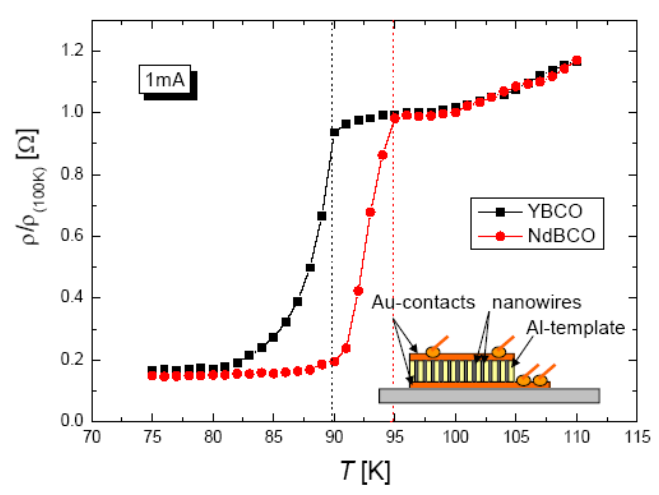
Figure 9. Resistance measurements on YBCO and NdBCO nanowire arrays fabricated using commer- cial AAO templates. The applied current was 1 mA. NdBCO shows the onset of the superconducting transition at 95 K, while YBCO has a T c of 88 K (indicated by red and black dashed lines). The inset illustrates the arrangement of the samples and the electrical contacts for a four-probe measurement. Au-films were evaporated onto the polished top and bottom surfaces of the AAO template to provide contacts to the nanowire